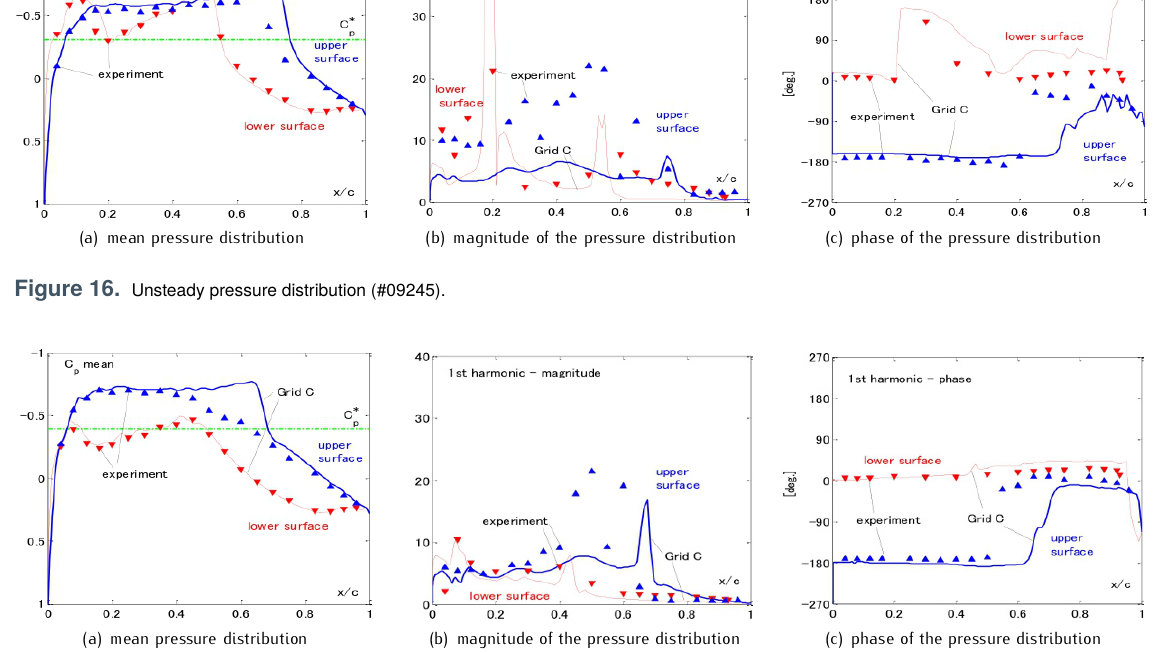
Figure 17. Unsteady pressure distribution (09254).